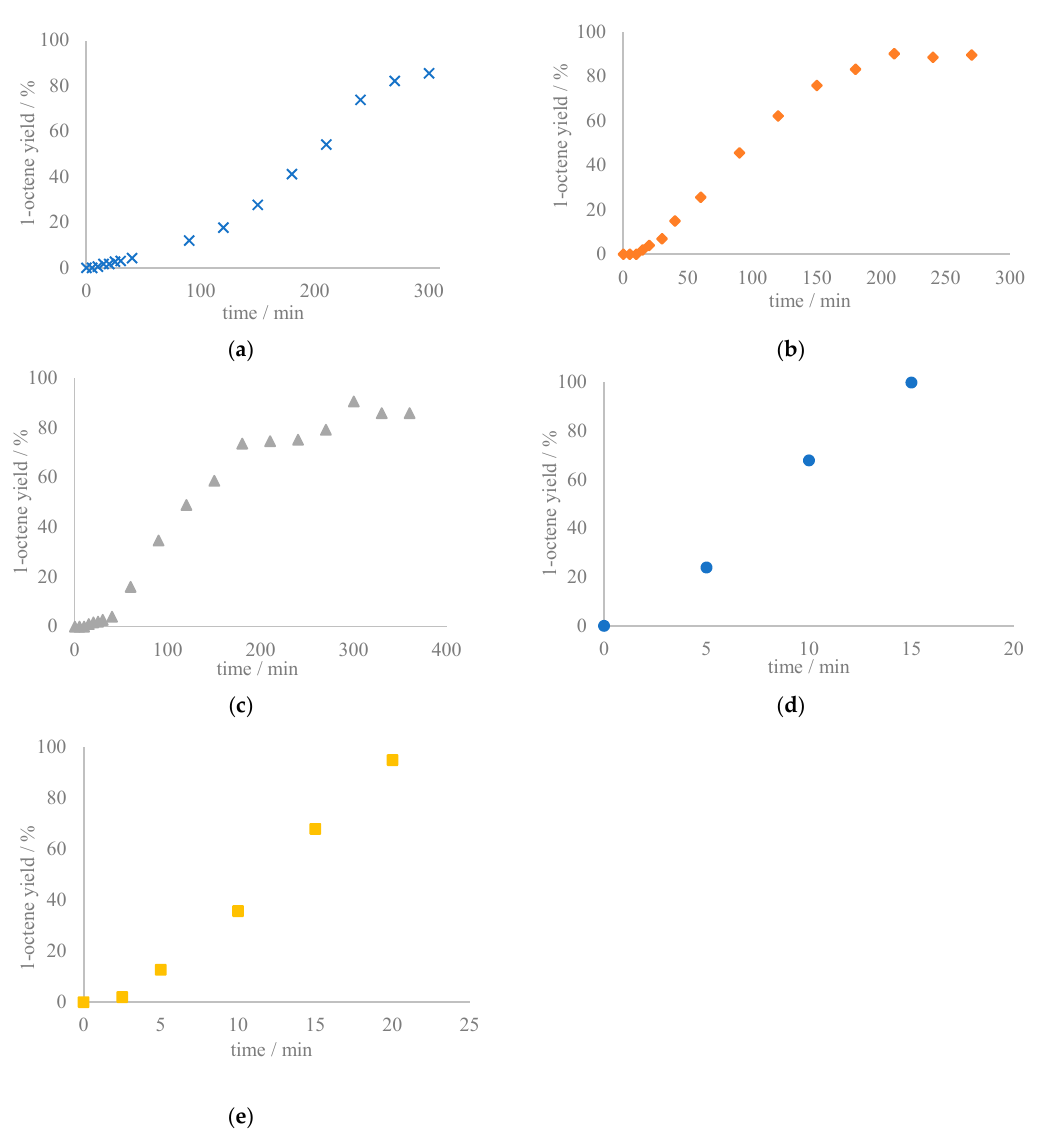
Scheme 5. Time-course profiles of the formation of 1-octene in Re-catalyzed DODH of